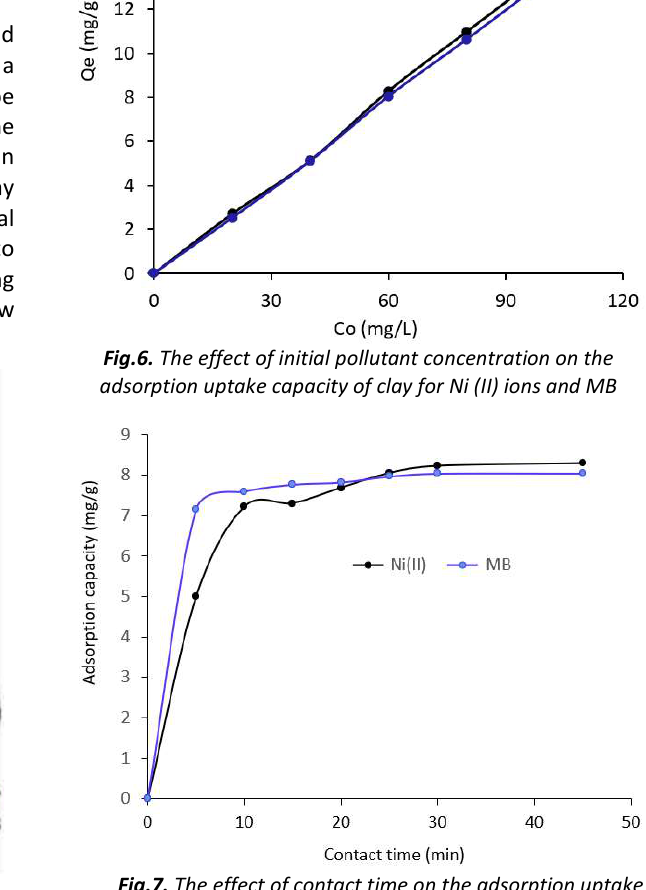
Fig.3. XRD pattern of natural clay